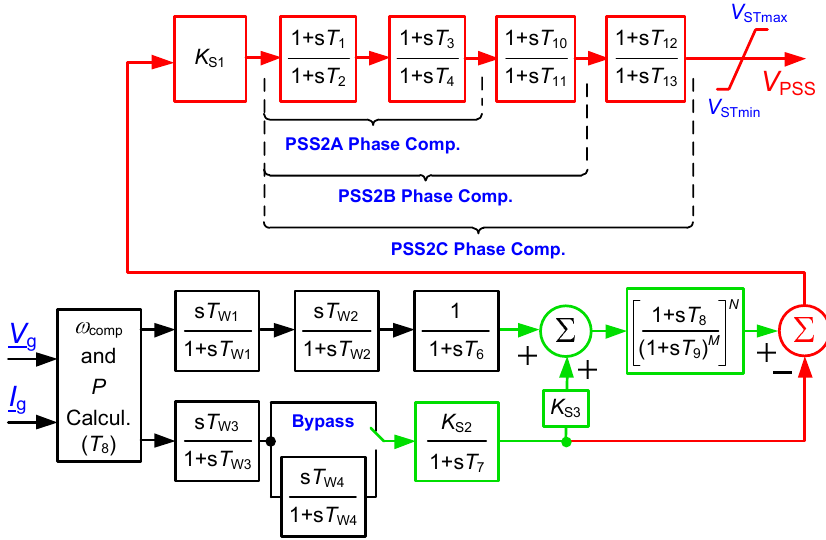
Figure 4. Block diagram of the PSS2C [18]. Table 1. Sample data (settings) for PSS2C stabilizer for ST1C model